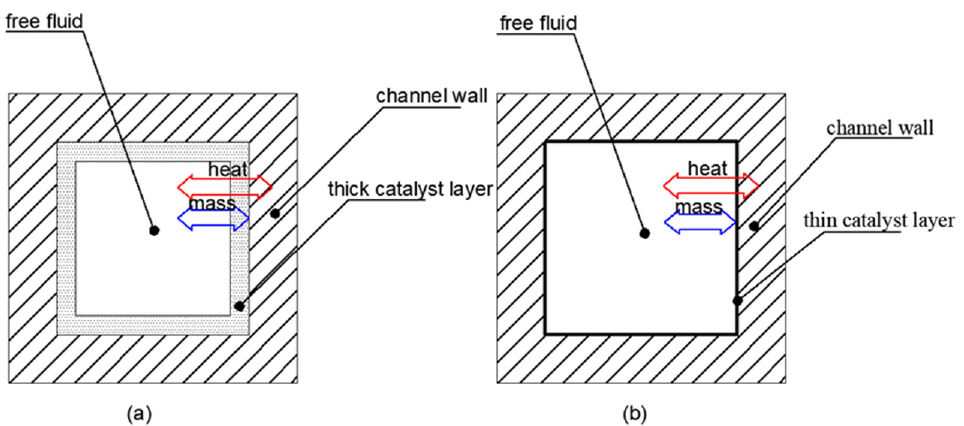
Figure 4. Cross section of microchannel reactor: ( a ) thick catalyst layer; ( b ) thin catalyst layer.